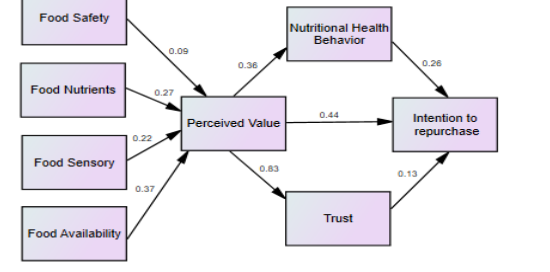
Fig 2. Modified Model of the Study